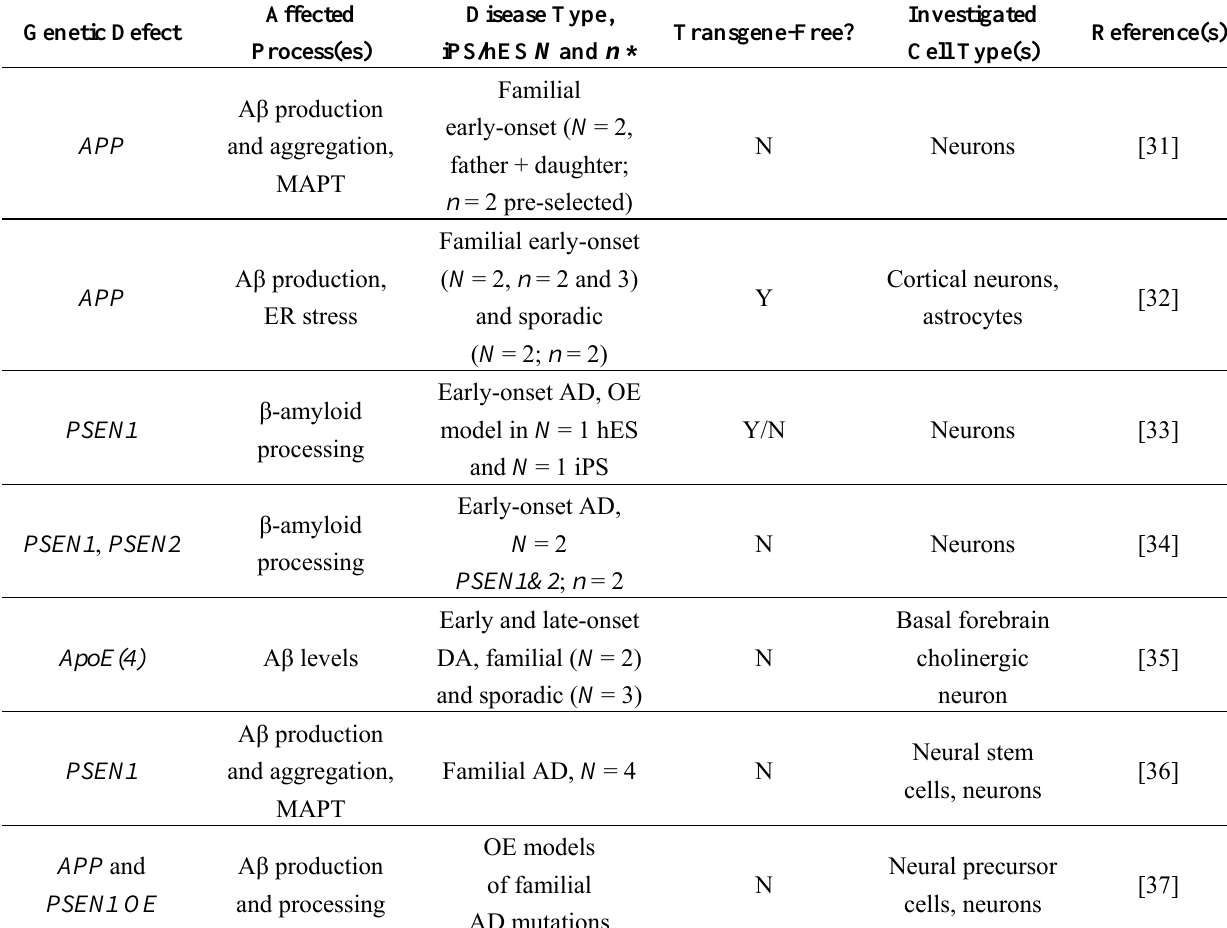
Table 1. iPSc models of Alzheimer’s